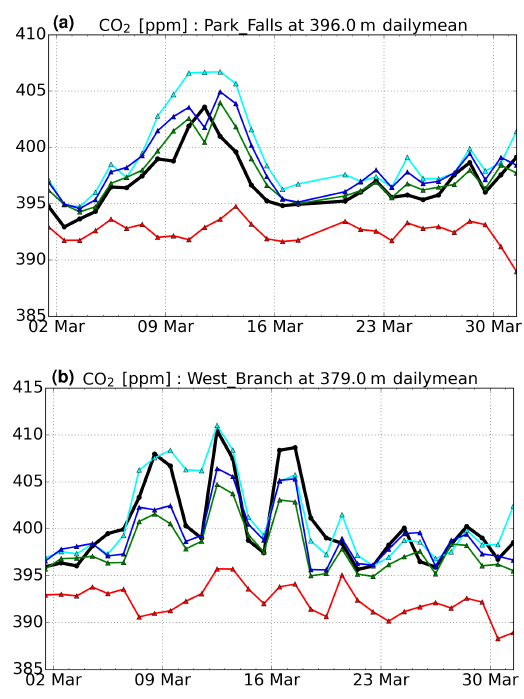
Figure 11. Daily mean atmospheric CO 2 dry molar fraction (ppm) in March 2010 from NOAA/ESRL tall towers (black circles) at (a) Park Falls (Wisconsin, USA, 45.95 ◦ N, 90.27 ◦ W) and (b) West Branch (Iowa, USA, 41.72 ◦ N, 91.35 ◦ W) and the different fore- cast experiments: BFAS (cyan), CTRL (red), OPT (green) and OPT- CLIM (blue) (see Table 2 for a description of the different experi-